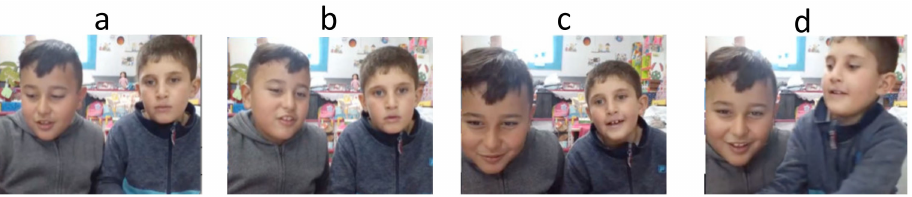
Figure 7. ( a ) Hitam (left) holding the mouse; ( b ) Hitam looking with interest at the screen; ( c ) Hitam leaning forward; ( d ) Pilo moving toward Hitam to take the